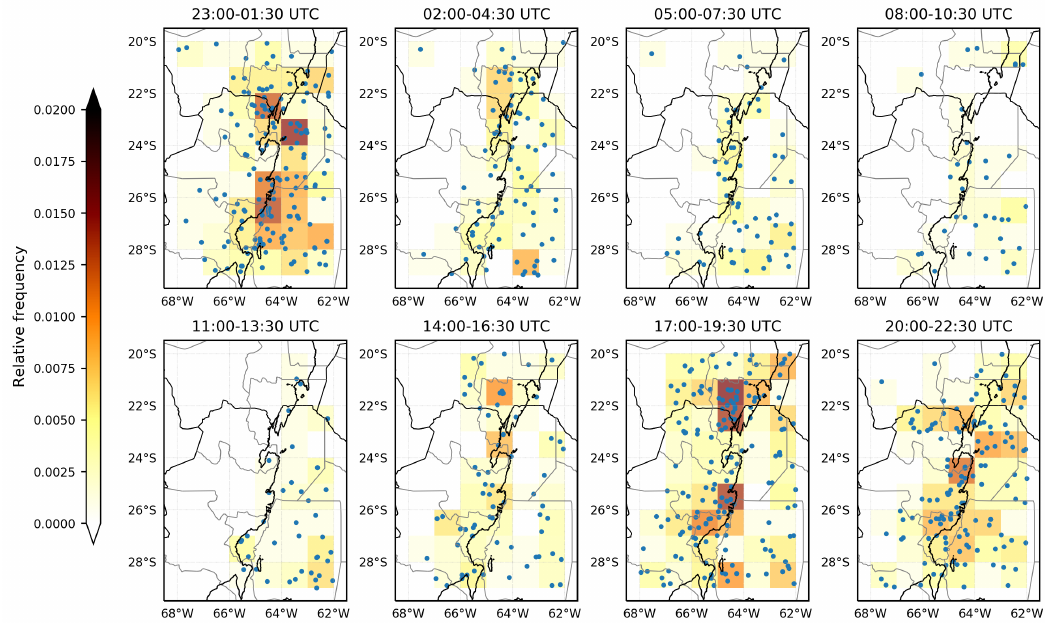
Figure 12. Same as Figure 11, but for the northwestern Argentina (NOA) region. CI sample size: 812.